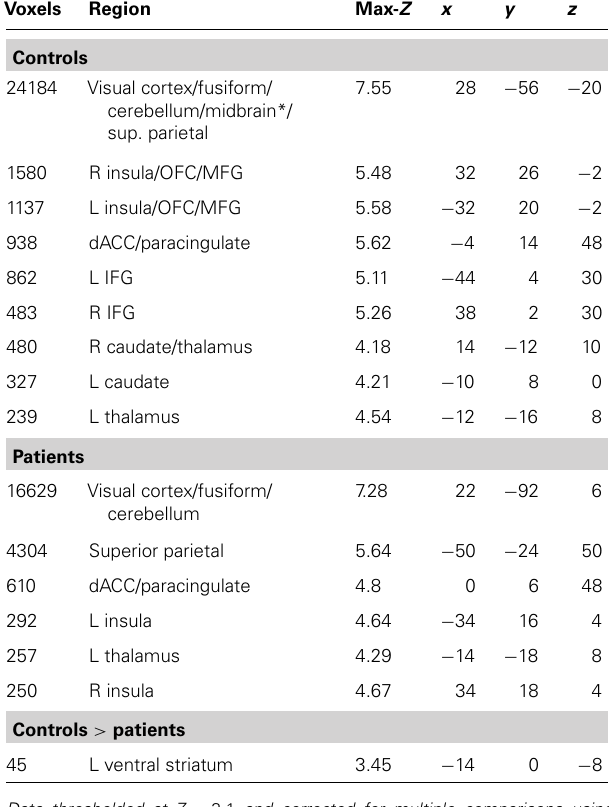
OFC, orbitofrontal cortex; MFG, middle frontal gyrus; IFG, inferior frontal gyrus; dACC, dorsal anterior cingulate cortex. Peak-Z x, y, z coordinates are in MNI space. *The cluster listed is in the right posterior midbrain; however, an adjacent subthreshold cluster was present in the right substantia